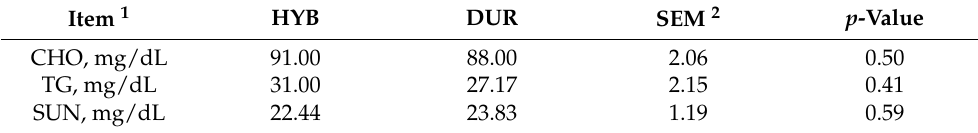
Table 5. Concentration of serum metabolites of pigs of different genetic lines.